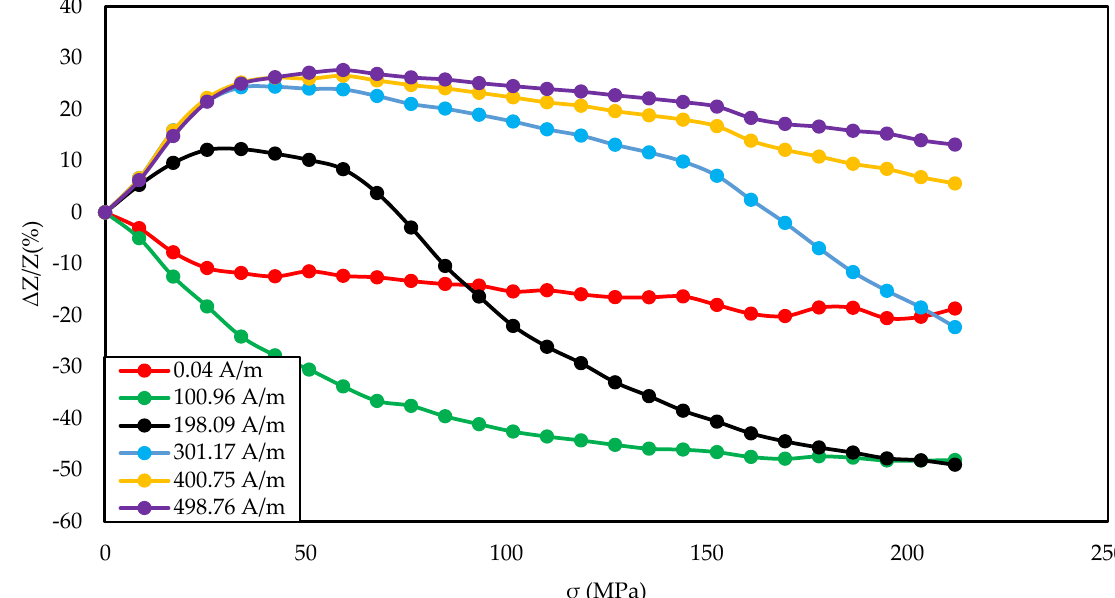
Figure 9. Dependence of impedance in a function of stresses for different magnetizing fields for the annealed by a 900 mA current sample.